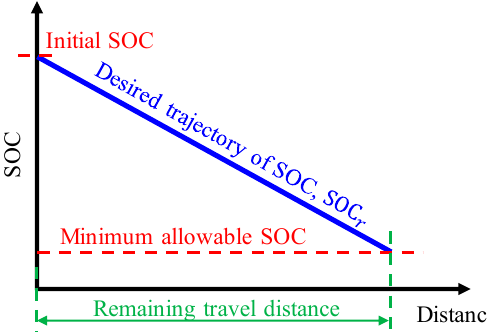
Figure 11. The relationship between PSR and J ECMS at the four modes.